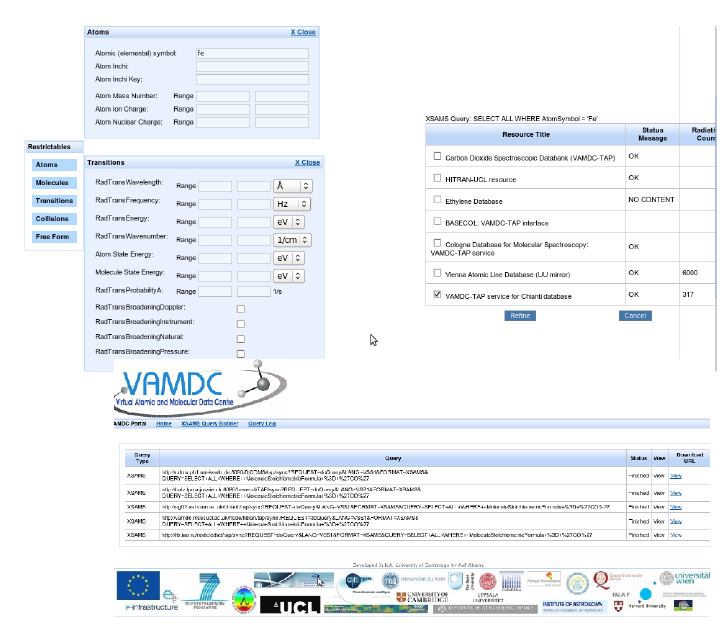
Fig. 1. The VAMDC Web